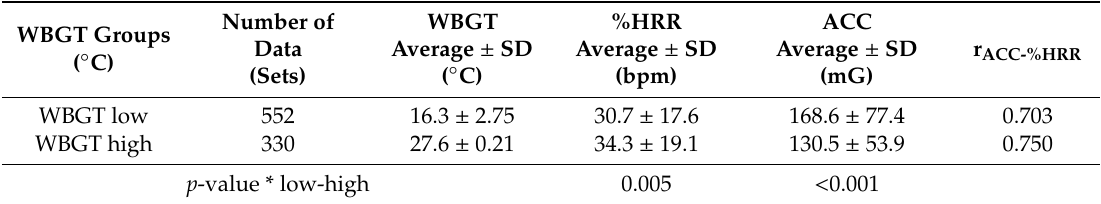
Table 8. Overview of wet bulb globe temperature (WBGT) and the relationship between ACC and %HRR.